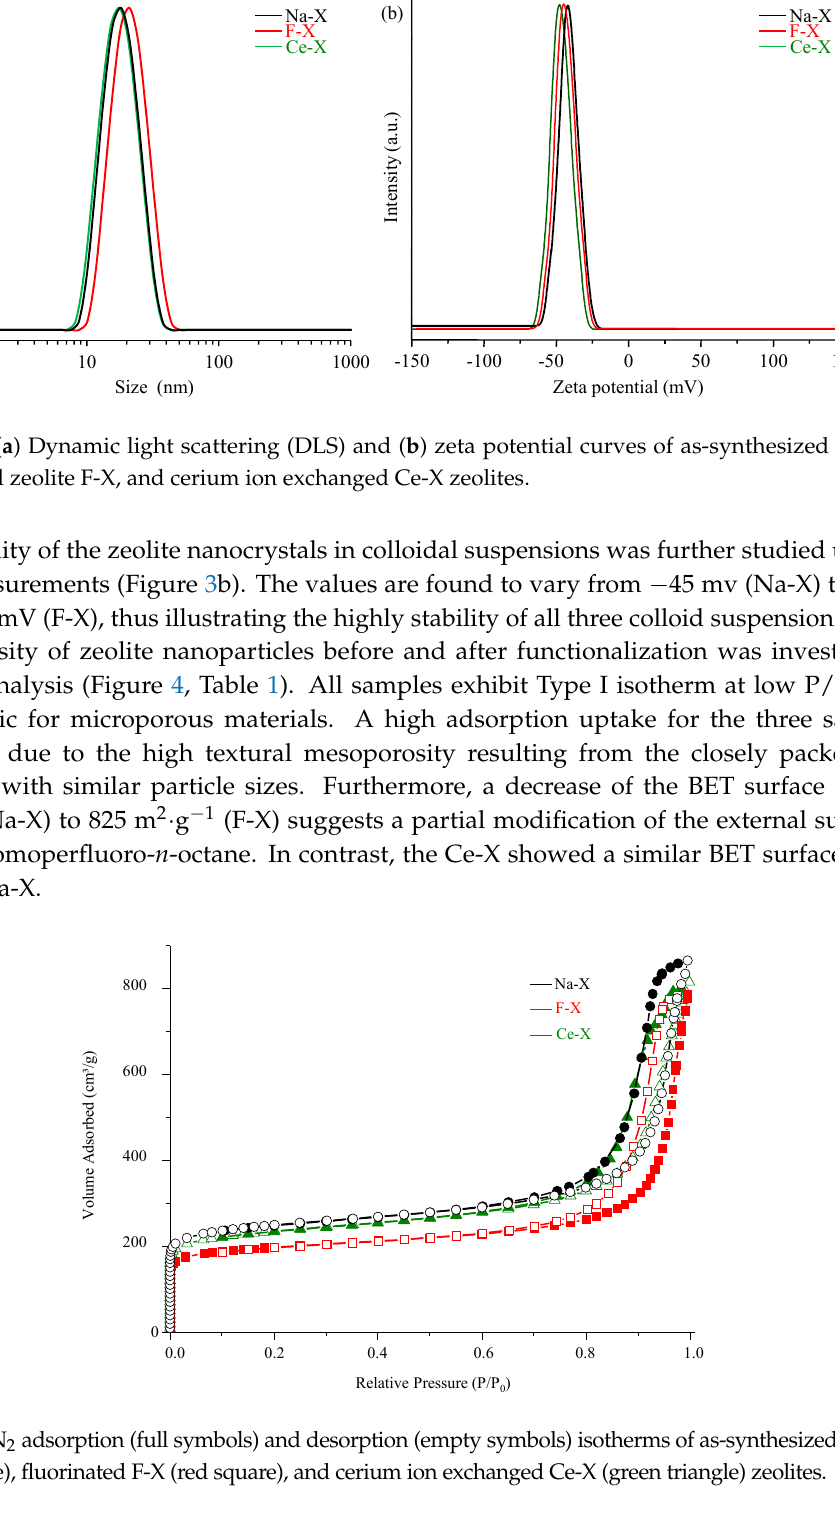
Figure 4. N 2 adsorption (full symbols) and desorption (empty symbols) isotherms of as-synthesized Na-X (black circle), fluorinated F-X (red square), and cerium ion exchanged Ce-X (green triangle) zeolites. Table 1. BET-specific surface area (S BET ), micropore volume (V mic ) and total pore volume (V total ) of as synthesized Na-X, fluorinated F-X, and ion exchanged Ce-X zeolites.